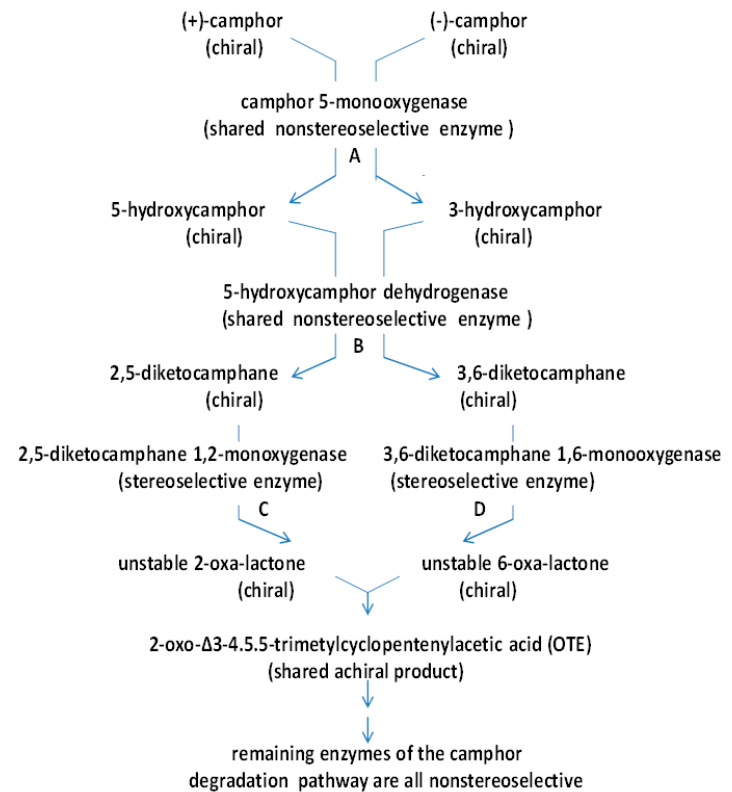
Figure 12. The relationships between nonselective and stereoselective enzymes that constitute the pathway for the degradation of ( rac )-camphor to OTE in P. putida ATCC 17453, and the roles of relevant chiral and achiral molecules as substrates and transcriptional regulators. A = induction by (+)-camphor and ( − )-camphor, plus product induction by OTE: B = induction by (+)-camphor and ( − )-camphor, plus product induction by 2,5-DKC and 3,6-DKC: C = induction by (+)-camphor, ( − )-camphor and 2,5-DKC, plus cross-induction by 3,6-DKC, and product induction by OTE: D = induction by (+)-camphor, ( − )-camphor and 3,6-DKC, plus cross-induction by 2,5-DKC, and product induction by OTE: A + B + C + D = ‘from the top’ coordinate induction by (+)-camphor and ( − )-camphor.